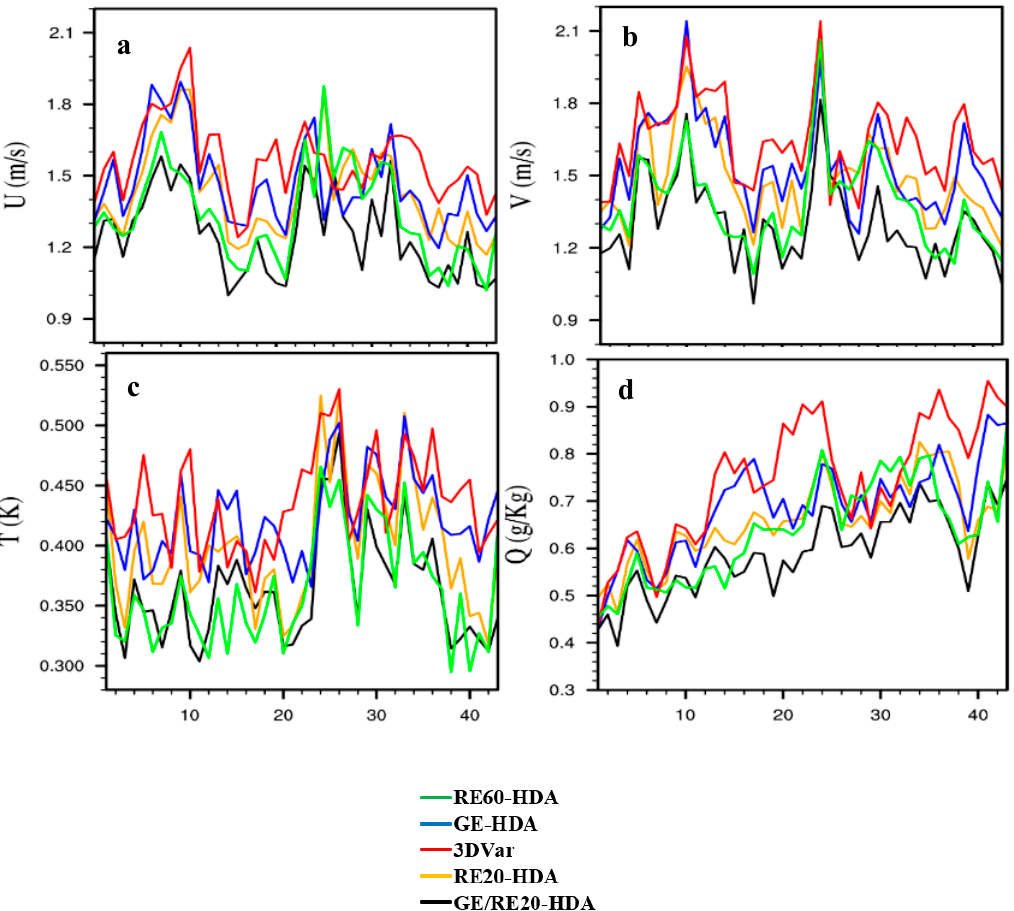
Figure 8. Time series of the average analysis RMSE at 500 hPa. Values on the x axis represent the analysis cycle numbers. (( a ) Zonal wind (m / s); ( b ) Meridional wind (m / s); ( c ) Temperature (K); ( d ) Water vapor mixing ratio (g / kg).)